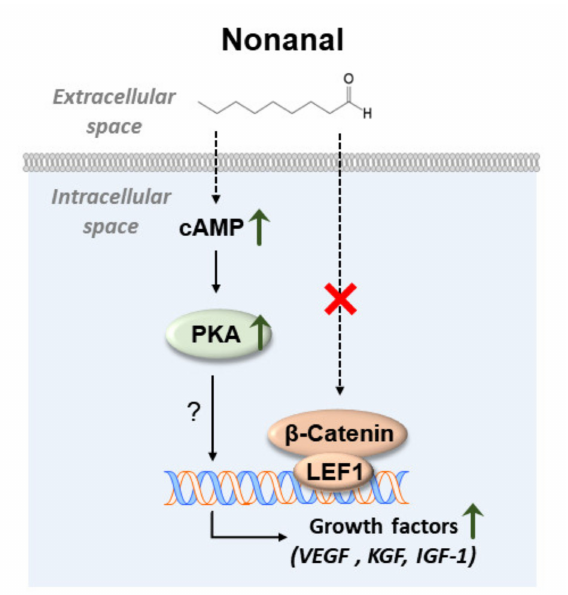
Figure 8. A suggested mechanism by which nonanal induces the growth factors expression in DPCs via the cAMP signaling pathway. As shown in a schematic illustration, stimulation of the cAMP signaling pathway in response to nonanal increases levels of growth factors such as VEGF, KGF, and IGF-1. The detailed molecular mechanism by which cAMP-mediated growth factor secretion increases needs further investigation. Interestingly, β -catenin and LEF1 levels did not increase in response to nonanal